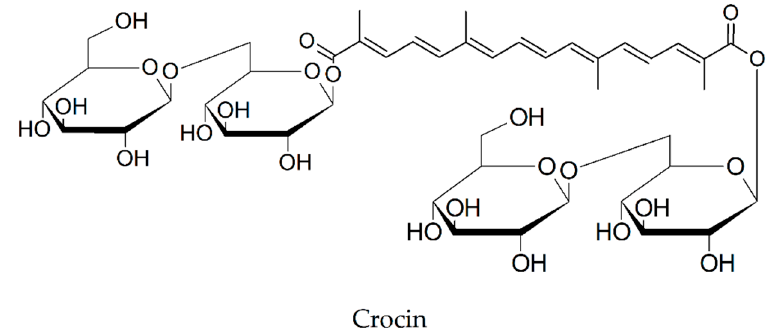
Figure 7. Chemical structure of crocin.